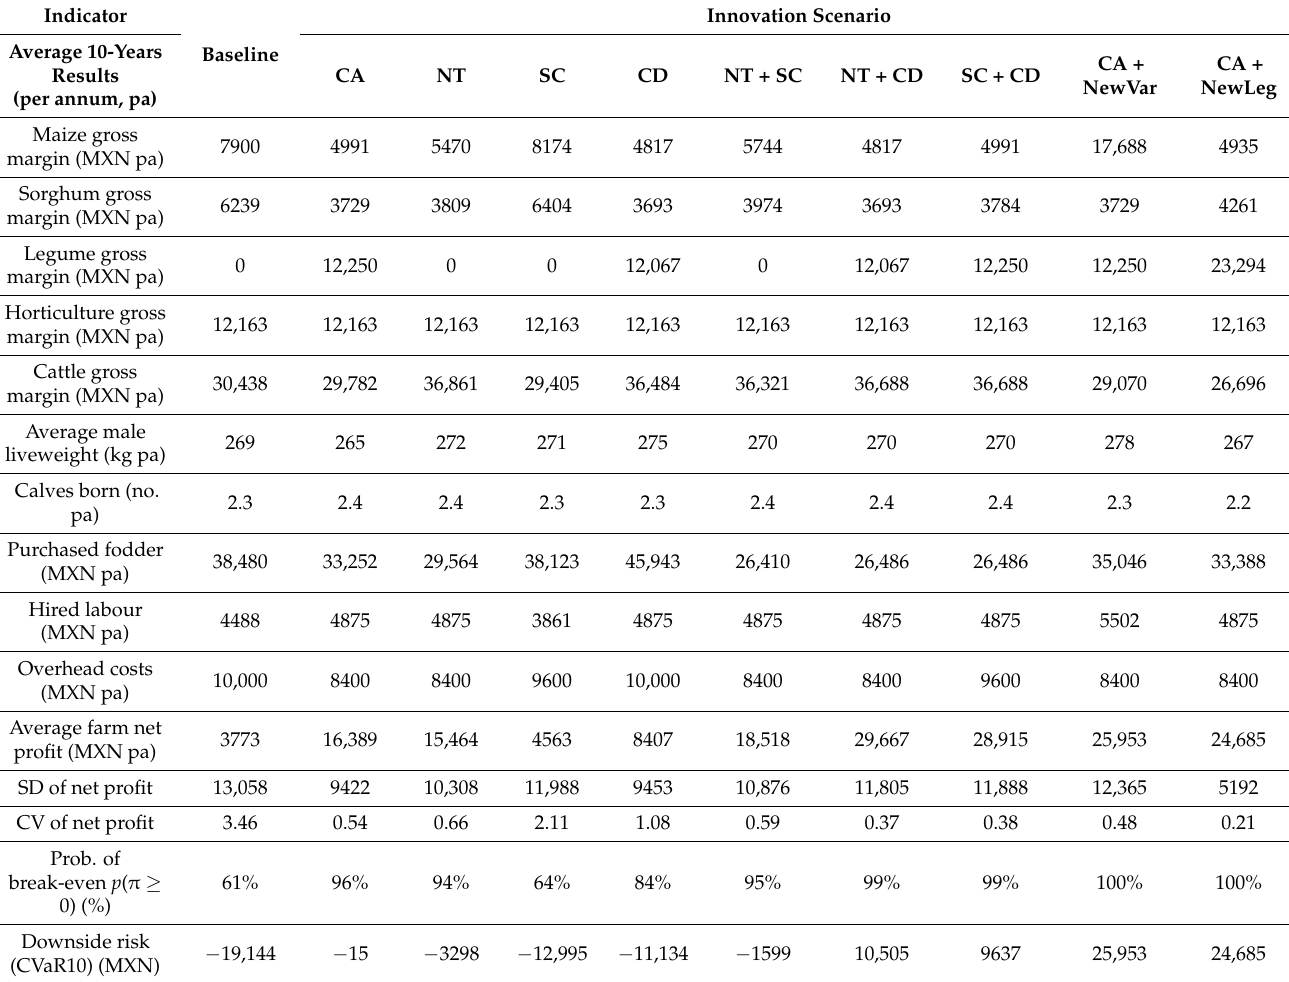
Table 2. Average economic and risk-neutral results from the IAT simulation and NPV analysis for the baseline and